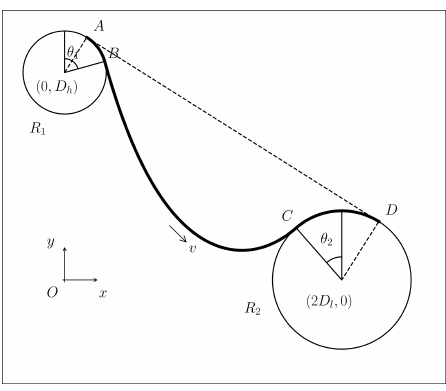
Figure 4. Flexible thin-sheet material between